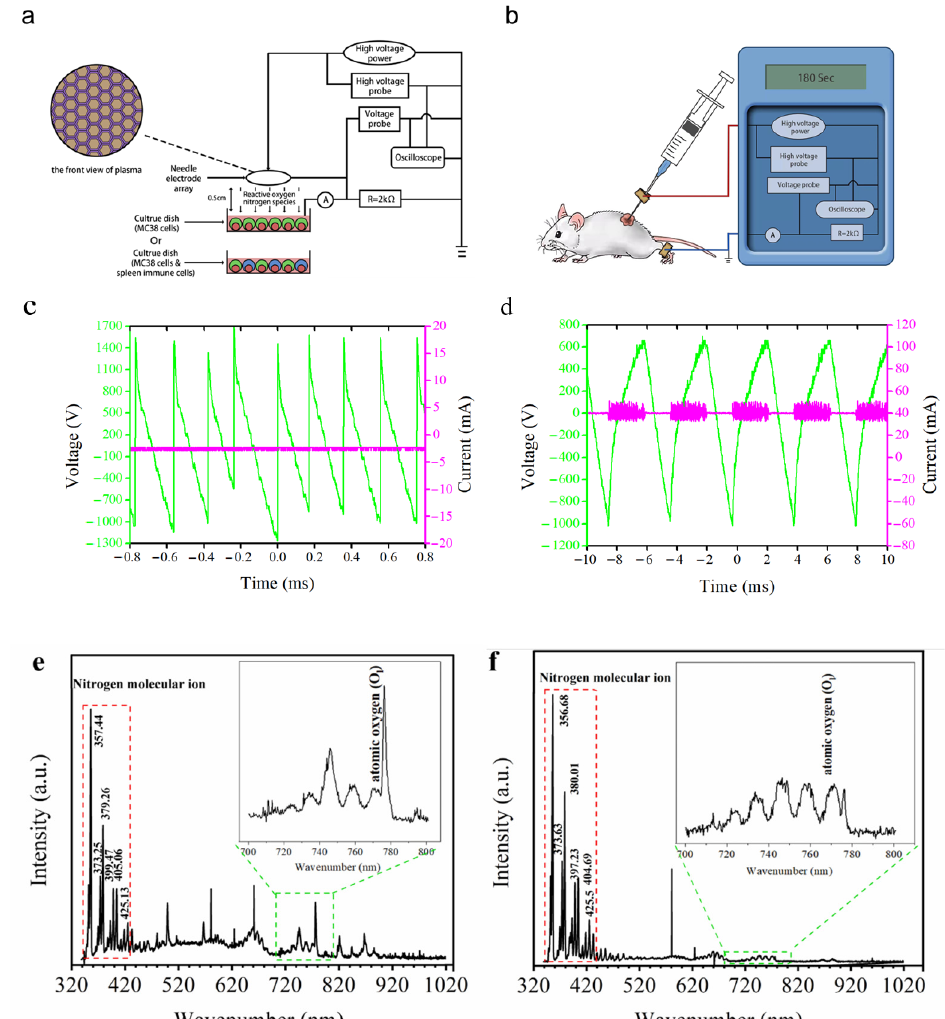
Figure 1. Schematic diagrams and characteristic parameters of the cold atmospheric plasma (CAP) devices for tumor treatment in vitro and in vivo. The schematic diagrams of the CAP devices for treating cells and mice are shown. ( a ) The in vitro device comprises an array of needle electrodes, a DC power supply, an oscilloscope, a high-voltage probe, a microammeter, a low-voltage probe, and a resistor. ( b ) The syringe is punctured into the skin of the mouse back above the tumor mass, and 5 mL of air is injected as the working gas. The syringe tip is used as the needle electrode connected to the plasma device by a copper piece. Another piece of copper is fixed to the left foot of the mouse and also connected to the ground electrode. The discharge duration is 180 s. ( c , d ) Voltage and current waveform of the multi-needle ( c ) and single-needle ( d ) devices. ( e , f ) Optical emission spectra of the multi-needle ( e ) and single-needle ( f ) plasma in the wavelength range of 340–1000 nm.